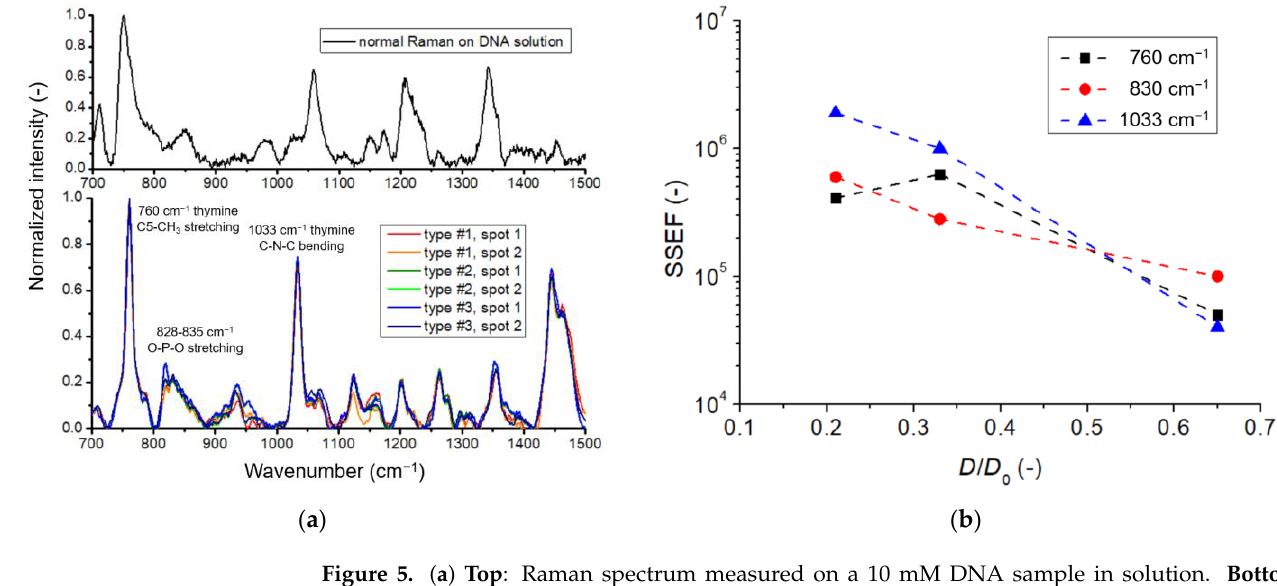
Figure 5. ( a ) Top : Raman spectrum measured on a 10 mM DNA sample in solution. Bottom : SERS spectra were obtained on three different substrates containing three different nanoparticle arrangements (type #1, #2, and #3, respectively). The spectra are baseline corrected and normalized to the peak intensity at 760 cm −1 . On every substrate, two spectra obtained in different spots are presented. ( b ) The substrate-specific SERS enhancement factor ( SSEF ) values, calculated for the three different nanoparticle arrangements, in the function of the dimensionless D / D 0 value, for three characteristic DNA-related peaks.